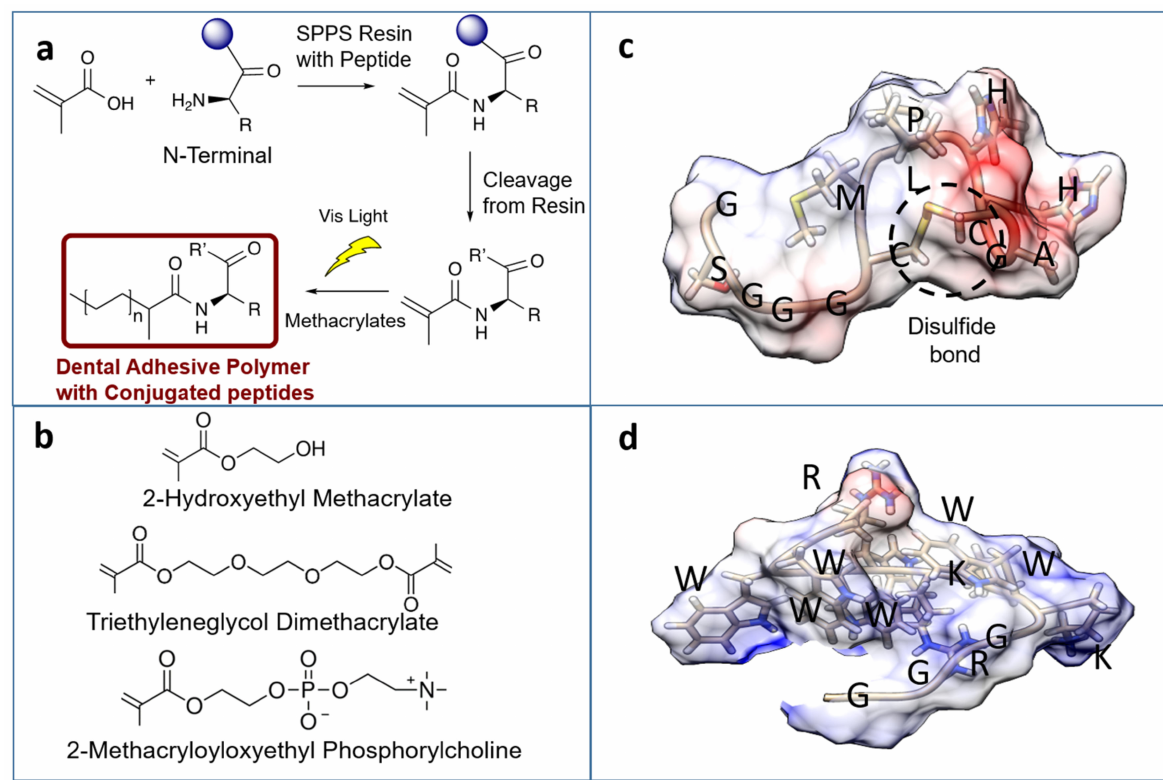
Figure 1. ( a ) Synthesis overview for dental adhesive polymer. ( b ) Methacrylate compounds used in dental adhesive polymer synthesis. ( c ) Bioactive peptide with HABP with spacer sequence (GSGGGCMLPHHGAC). ( d ) Bioactive peptide for AMPM7 (GSGGGKWKRWWWWR-NH2). The peptide surfaces are colored by electronegativity through the Coulombic surface tool in UCSF Chimera 1.13. Structures generated using PyRosetta folding